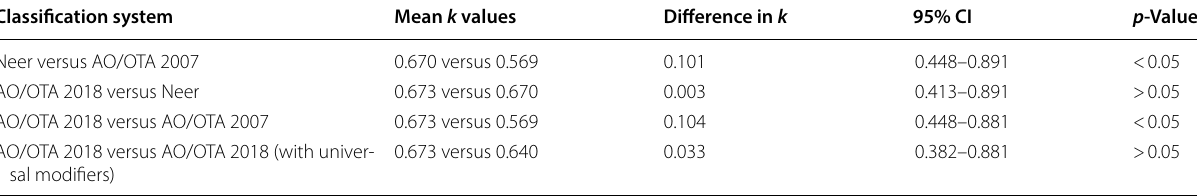
Data acquired from interobserver testing from mean k values of two readings (Tables 1, 2, 3, and